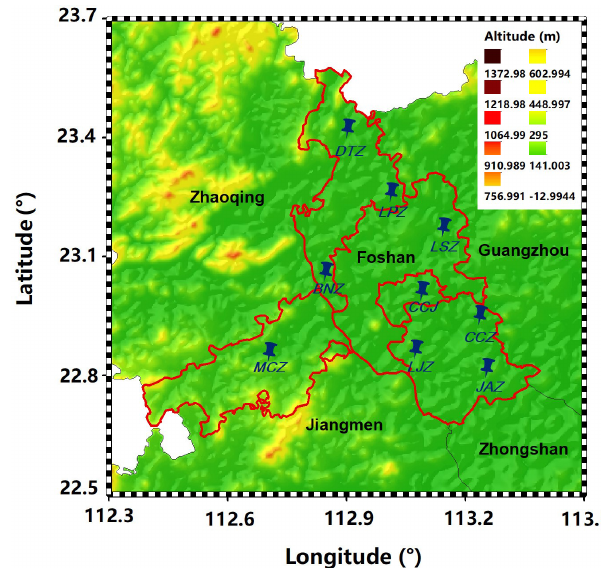
Figure 1. Geographical distribution of the Foshan total lightning location system (FTLLS), in which a full operation of nine stations in the Foshan area is shown. Station location is displayed by blue